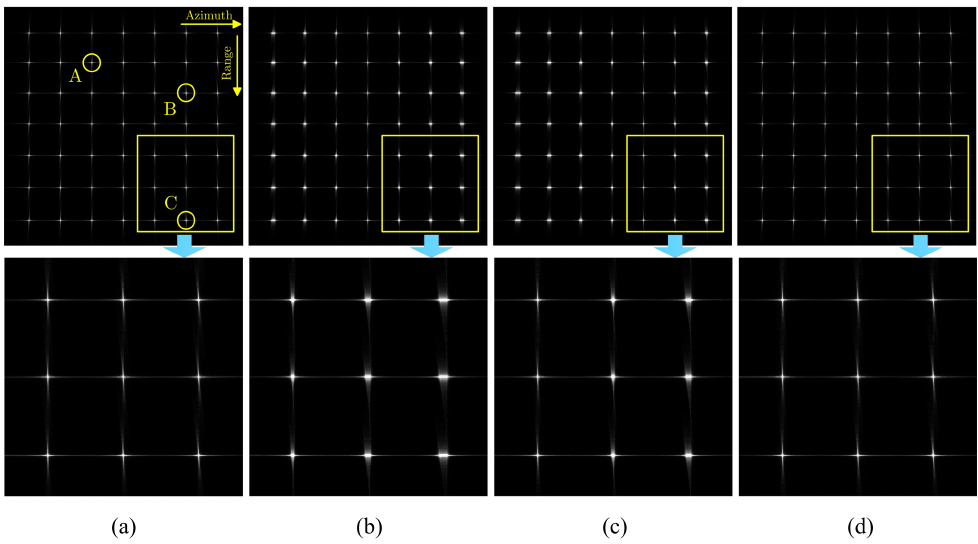
Figure 10. Ka-band point target simulation and magnified sub-scene. ( a ) Ideal point image. ( b ) Azimuth-variant error interfered image. ( c ) Processed with conventional MDA. ( d ) Processed with AVMDA.